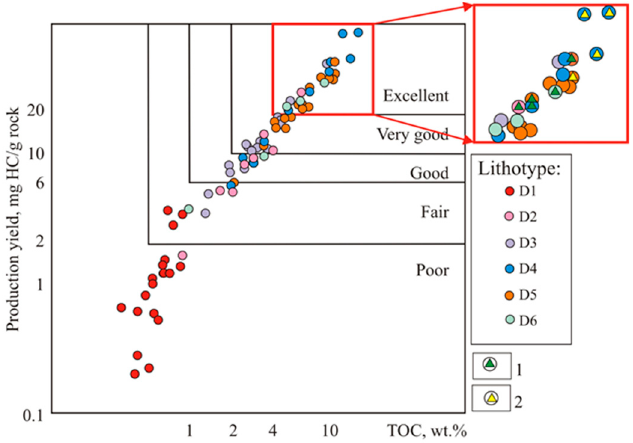
Figure 4. Production yield (S0 + S1 + S2) versus TOC correlation (after [20]) characterizing generation potential of different lithotypes. Zooming of area for samples with atypical S4 peak (1—samples of non-distinct separation of the peaks S4 and S5; 2—fully superimposing S4–S5). Degree of catagenetic transformation of OM is evaluated as “mature” due to average Tmax_ex = 443 °C and production index PI 0.15-0.35, it corresponds to the middle of the main oil-generation zone (oil window) (the MC 2 stage at the catagenesis scale of Vassoyevich [21]), i.e., OM is at the peak of oil generation.